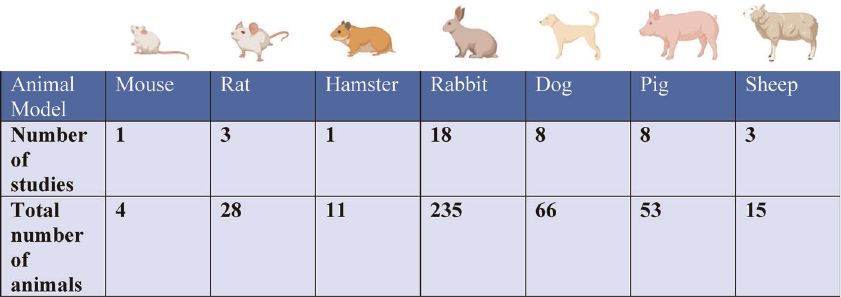
TABLE 1 The number of studies and total number of animals evaluated for each animal